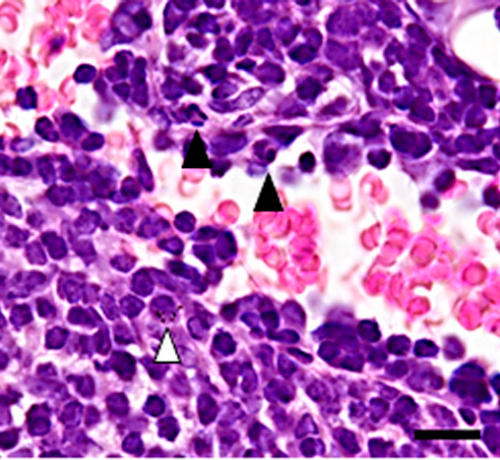
Figure 4. Histological changes of the lymph nodes taken from mice treated with 50 mg/m 3 of the powder for one day. Increased number of neutrophils (black arrowheads) and a macrophage containing the particles in the sinus (a white arrowhead). HE. Bar = 50 µm.